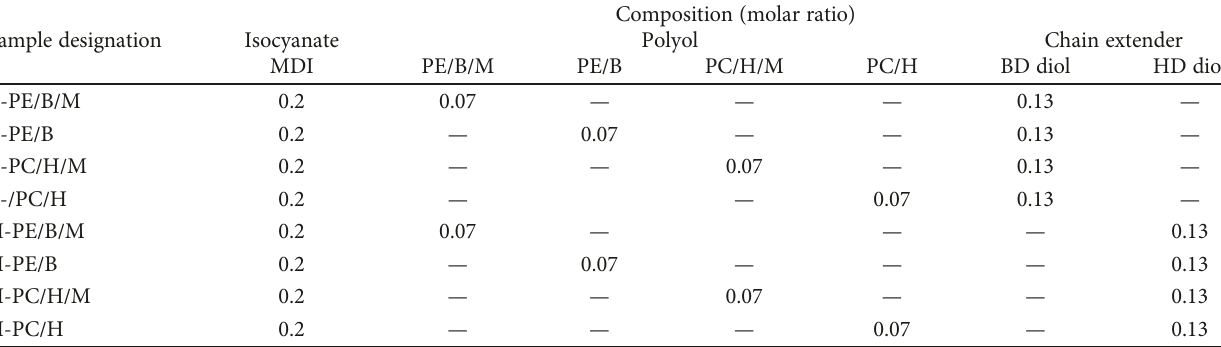
Table 2: Sample designation and composition of wet-type